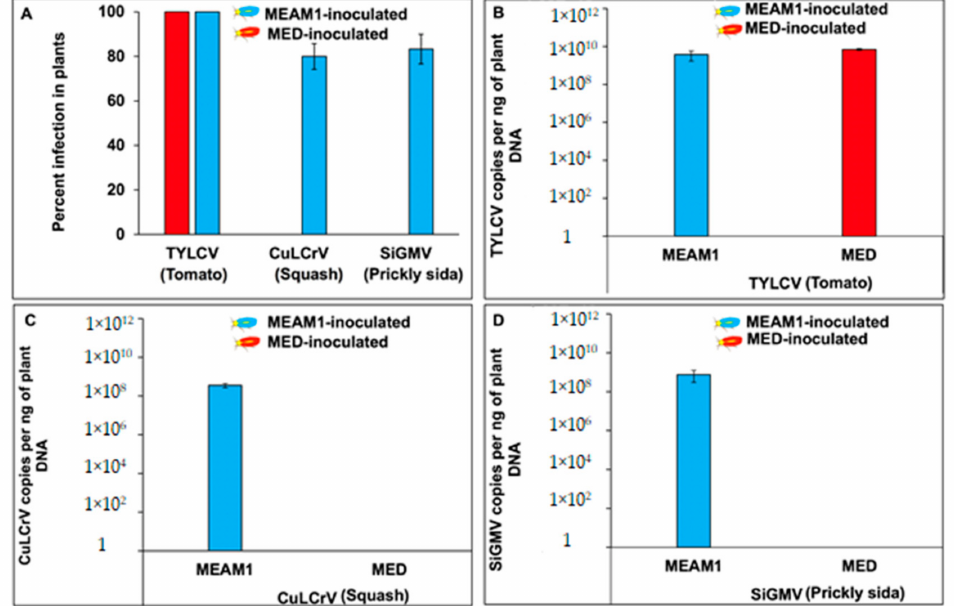
Figure 1. Percent virus infection and virus accumulation in plants inoculated with viruliferous B. tabaci MEAM1 and B. tabaci MED. ( A ), Bars with standard errors indicate percent TYLCV,